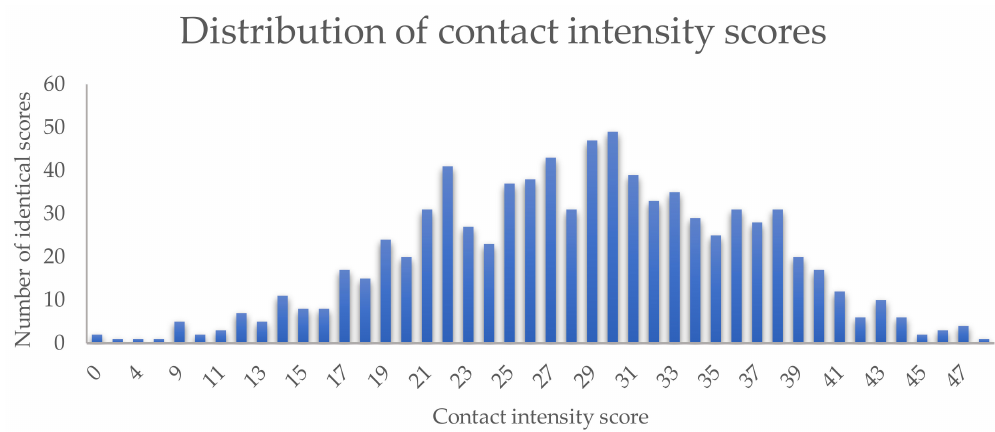
Figure1. Distributionofdog–ownercontact intensity scores. Theauthorsclassified di ff erentinteractions according to intensity. “Highly intense” interactions were those where the transmission of secretions, e.g., saliva, between a dog and its owner may occur. “Intense interactions” were defined as interactions where direct contact between a dog and its owner takes place. The nature of “less intense interactions” was indirect contact. Each category was assigned a score: 1 for less intense interactions (number of interactions ( n = 5), 2 for intense interactions ( n = 13), and 3 for highly intense interactions ( n = 7) (Table 1). Hygiene measures taken by a respondent were assigned a negative score ( − 1, n = 2). By summing up the di ff erent scores per respondent, an individual contact intensity score (maximum of 52 points) was obtained. A more intense contact resulted in a higher score. Table2. Themultivariableregressionmodelwiththedog–ownercontactintensityscoreasthedependent variable. The gender, age, and place of residence of a respondent, as well as the age and size of a dog were significantly associated with the dog–owner contact intensity score. Linear regression with a stepwise backward model-building procedure was used and the statistical significance was assessed at p < 0.05. The table is based on 701